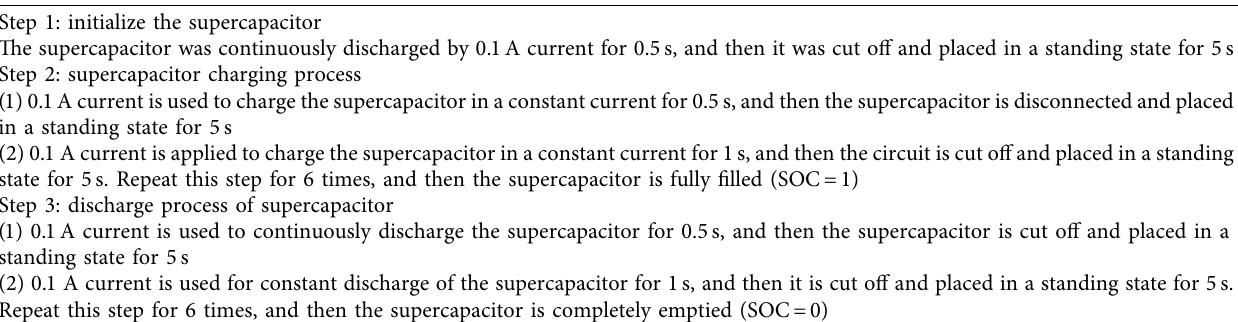
Figure 4: (a) The NI PCI 6221 acquisition card; (b) experimental platform of supercapacitor and lithium battery charged state estimation system. Table 1: Experimental steps of the relationship between open circuit voltage and SOC function of